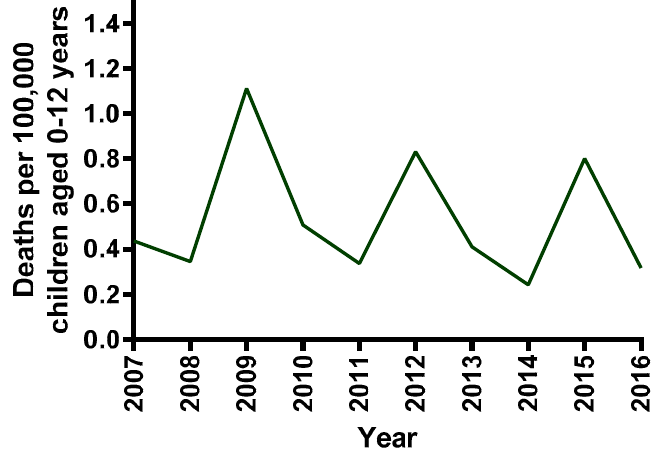
Figure 2. Rate of NSW child passenger (0–12 years) deaths per 100,000 children, 2007–2016.